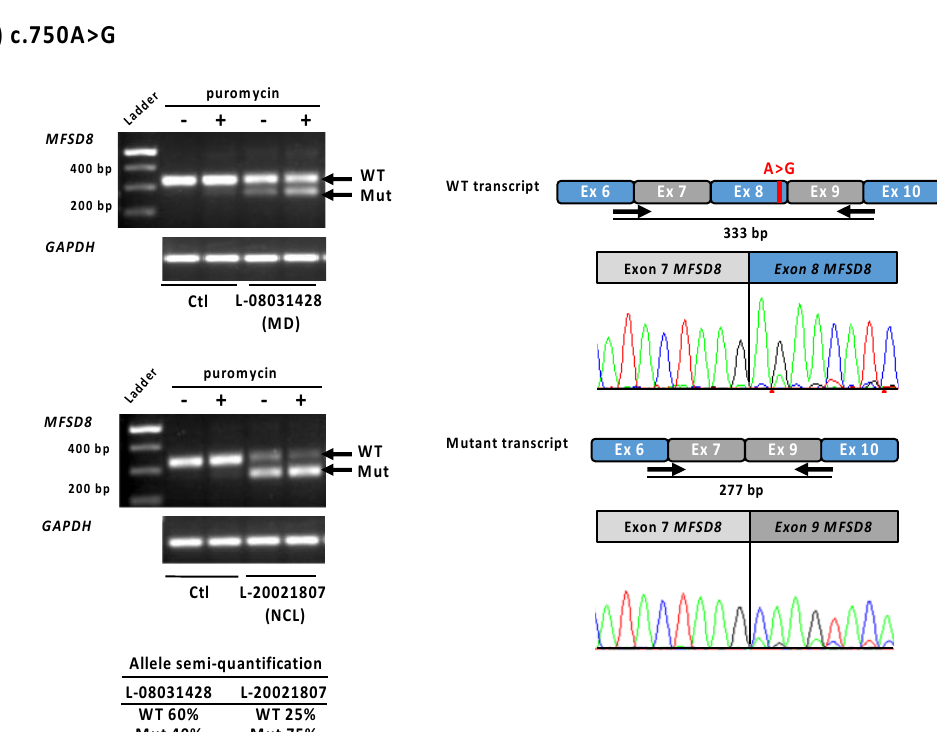
Figure 4. Functional tests results for MFSD8 variants c.998+1669A>G and c.750A>G in LCLs Lym- phoblastic cell lines from patients HD-OPH1206, L-08031428 and L-20021807 were used to analyse MFSD8 cDNA expression. ( a ) Overlapping primers located at the exons 9–10 and 11–12, respectively were used to show the inclusion of a 140 bp pseudoexon due to the c.998+1669A>G variant. On the right, electropherograms obtained from the upper and lower bands separated on agarose gel. ( b ) The exon 8 skipping due to c.750A>G variant was confirmed using primers located at exons 6–7 and 9–10 junctions. The exon 8 skipping is observed in control at a very low level, suggesting exon 8 as an alternative cassette, normally expressed, and enhanced by the presence of this variant. Semi- quantification of the bands (using primers located in exon 7 and 9) has been performed on cells not treated by puromycin. Ctl—control; MD—macular dystrophy; NCL—neuronal ceroid lipofushi- nose.